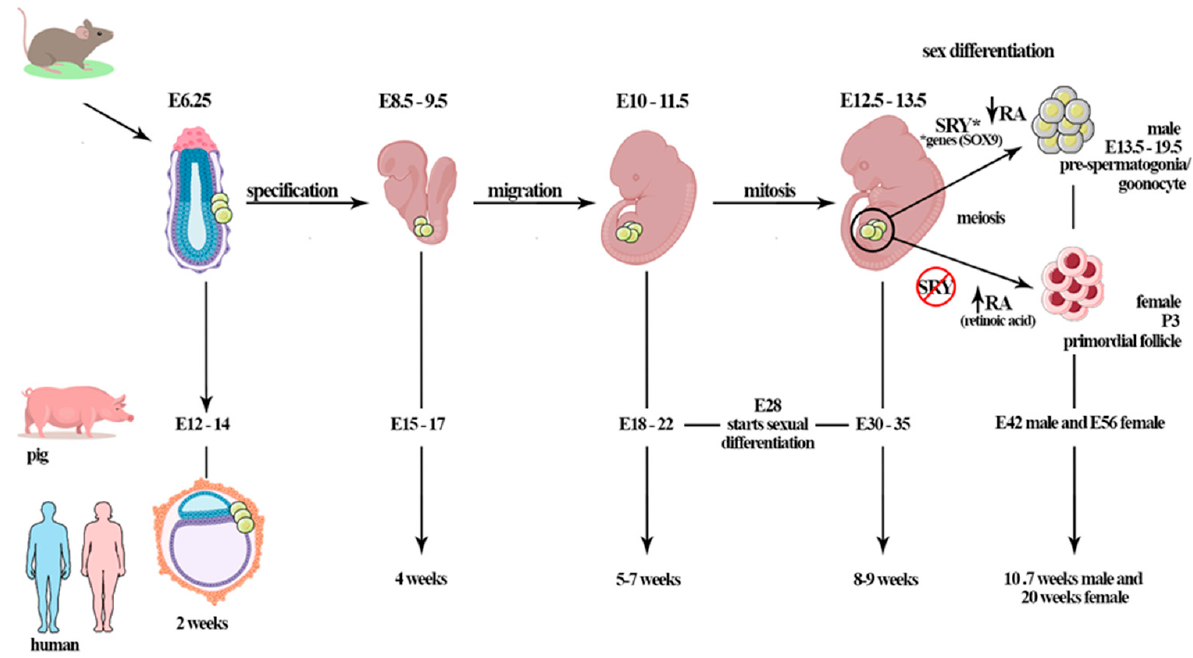
Figure 1. The mammalian gametogenesis process starts after the primordial germ cells (PGCs) complete the migration process to the gonadal ridge. The PGCs migration window is specific for each mammal species (e.g., ~E8–9.5 days for mice, ~E15–17 days for pigs, ~E25–30 days for cows, and ~4 weeks for humans). During PGCs colonization, the gonads are undifferentiated and, morphologically, are apparently identical (bipotential period). In porcine, gonadal differentiation starts at 28 days of gestation; however, complete differentiation is observed at E30–35 days of gestation. By E42, males have gonocytes in differentiated gonads; in females, the first primordial follicle is observed at E56 d.p.c in the fetal ovary. In mice, the germ cells of embryos at day E12.5 are morphologically undifferentiated; however, initiation of sex differentiation occurs at E13.5 days; the gonocytes are found from E13.5 until birth. In humans, PGCs colonize the genital ridge at 5–7 weeks (~E37), oogonia proliferation occurs until 10 weeks when the cells enter meiotic prophase, and primordial follicles are observed at 20 weeks of gestation. Sex determination is orchestrated by the SRY gene on the Y chromosome. *The expression of the SRY gene promotes testis formation through the activation of other genes (testicular genes, e.g., other factors and genes such as SOX9) during sex differentiation. The retinoic acid (RA) plays important role when PGCs enter meiosis. The female germ cells start meiosis after RA action, differently from males, in which meiosis pathway is inhibited by the RA-degrading enzyme CYP26B1.This period is gonadotropin-independent, although Sertoli cells expresses FSHR, that starts to act after birth.